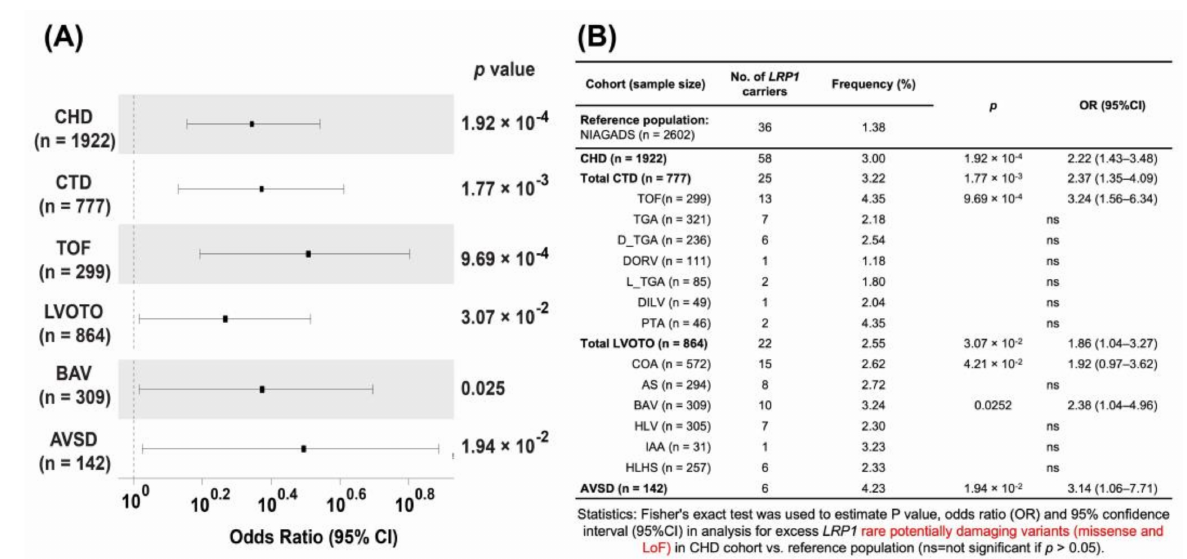
Figure 4. Rare LRP1 variants are associated with congenital heart defects. Illustration showing the position of rare LRP1 PDVs found in congenital heart defect (CHD) patients. ASD-atrial septal defect; AVSD-atrioventricular septal defect; CHD-congenital heart defect; CTD-conotruncal defect; LVOTO-left ventricular outflow tract obstruction; VSD-ventricular septal defect.